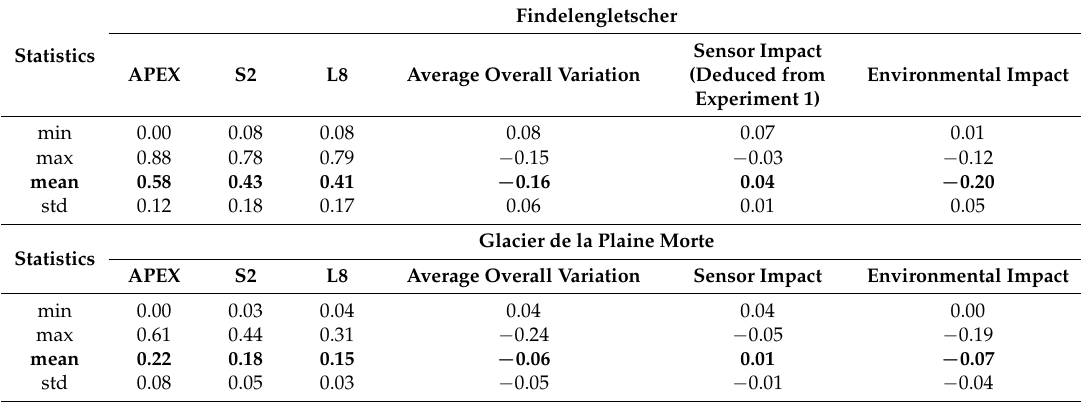
Table 2. Glacier-wide albedo statistics of albedo products from different datasets for Findelengletscher ( top ) and Glacier de la Plaine Morte ( bottom ) derived with the SBA ani algorithm. Overall variation (difference between APEX and S2/L8) and related sensor and environmental impact are given.